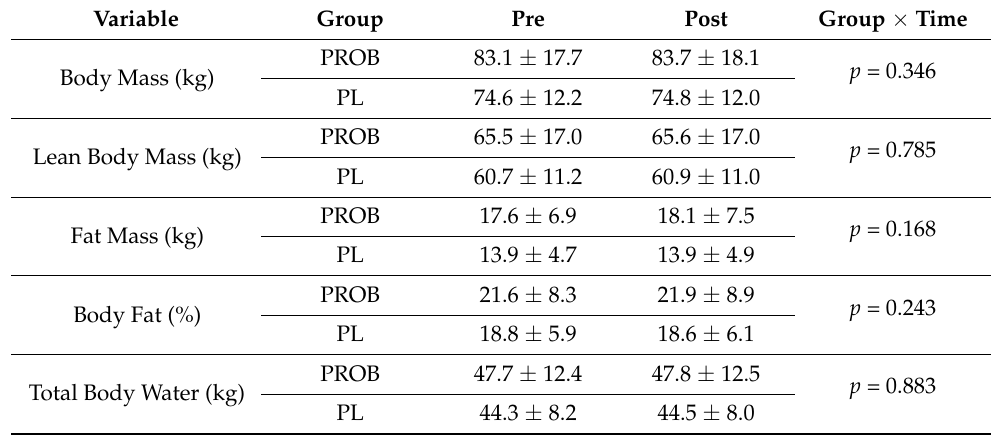
Table 2. Body Composition Values Before and After Supplementation